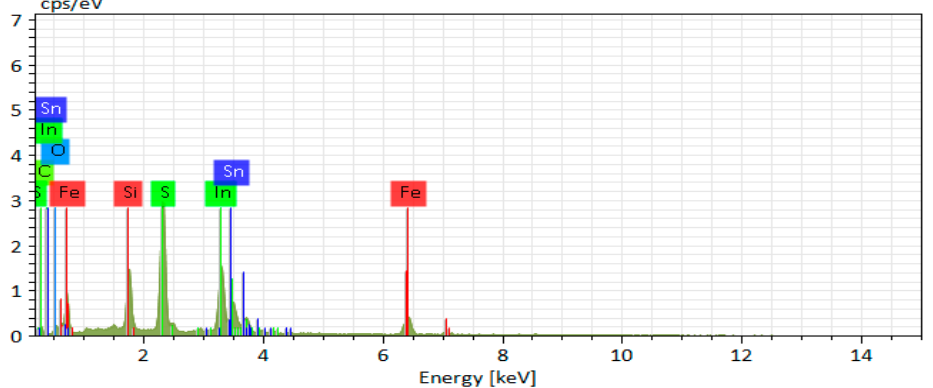
Table 2. Atomic percentage of iron pyrite film.